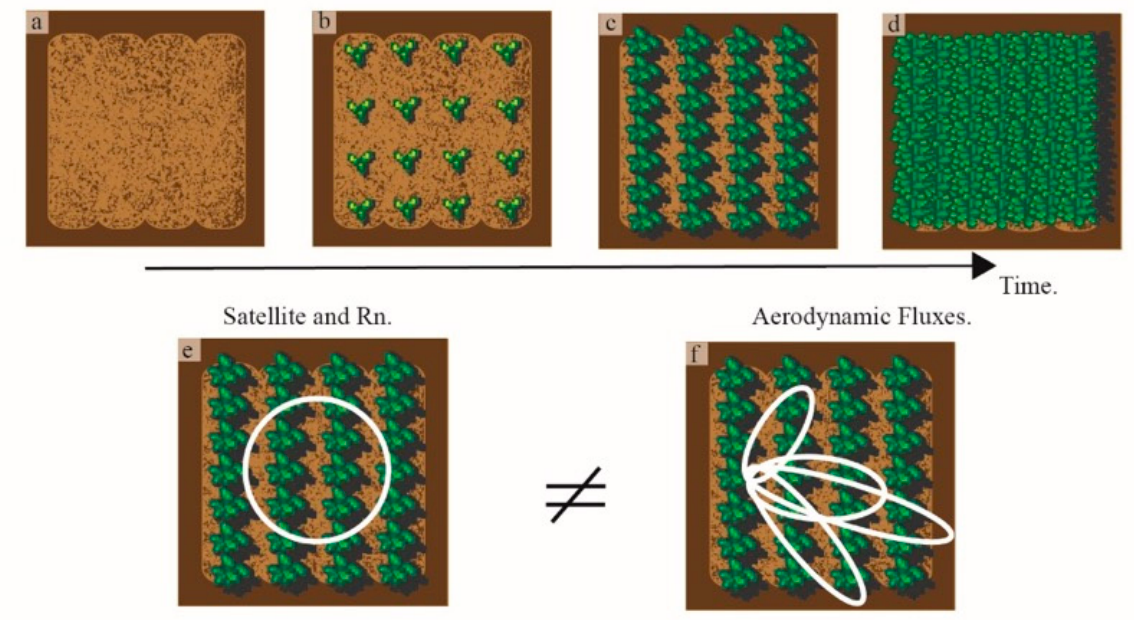
Figure 1. Geometric configuration of plants in a ridge-furrow agricultural crop across time ( a – d ) and the complex differences between footprint from different observations; ( e ) satellite and in situ Rn measurements; and ( f ) flux-based methods such as eddy